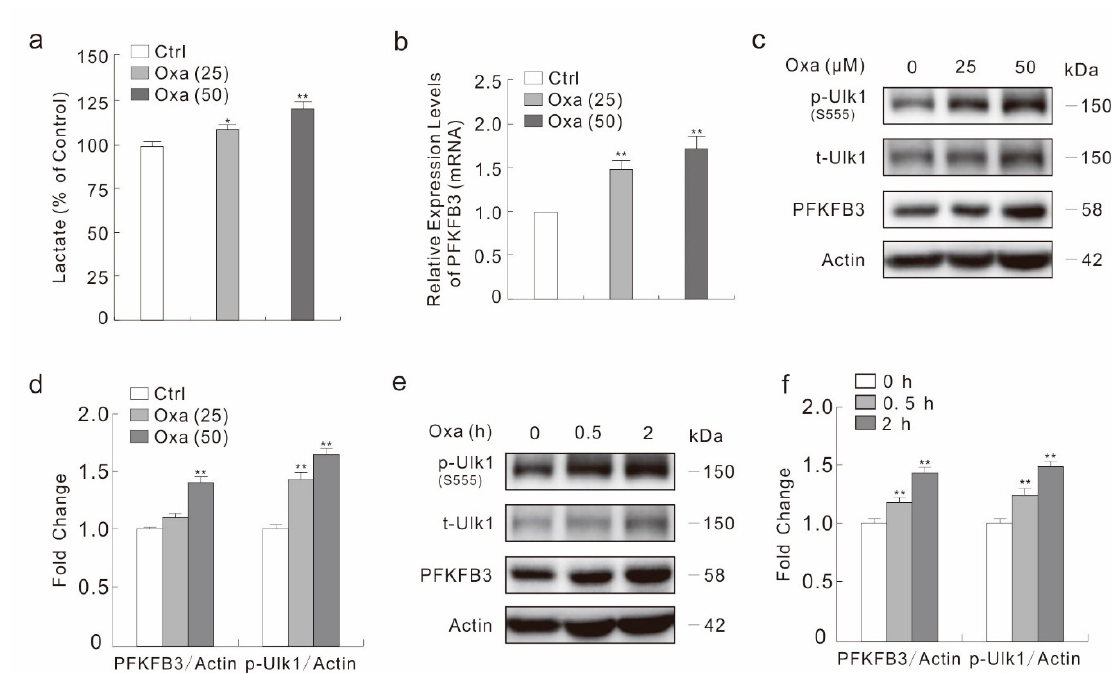
Figure 3. Oxa up-regulates the expression of PFKFB3. ( a ) Following treatment with Oxa for 6 h, culture media were collected and subjected to lactate assay. ( b ) Real-time PCR was performed to detect the mRNA expression of PFKFB3 following treatment with Oxa for 6 h. ( c – f ) SW480 cells were treated with Oxa ( e : 50 µ M) upon to 2 h ( c : 2 h). Cell lysates were subjected to immunoblotting with the indicated antibodies, and the relatively ratios of PFKFB3 and p-Ulk1 to Actin were shown in the histogram graphs. * p < 0.05 vs. control, and ** p < 0.01 vs. control. Data represent three independent experiments.